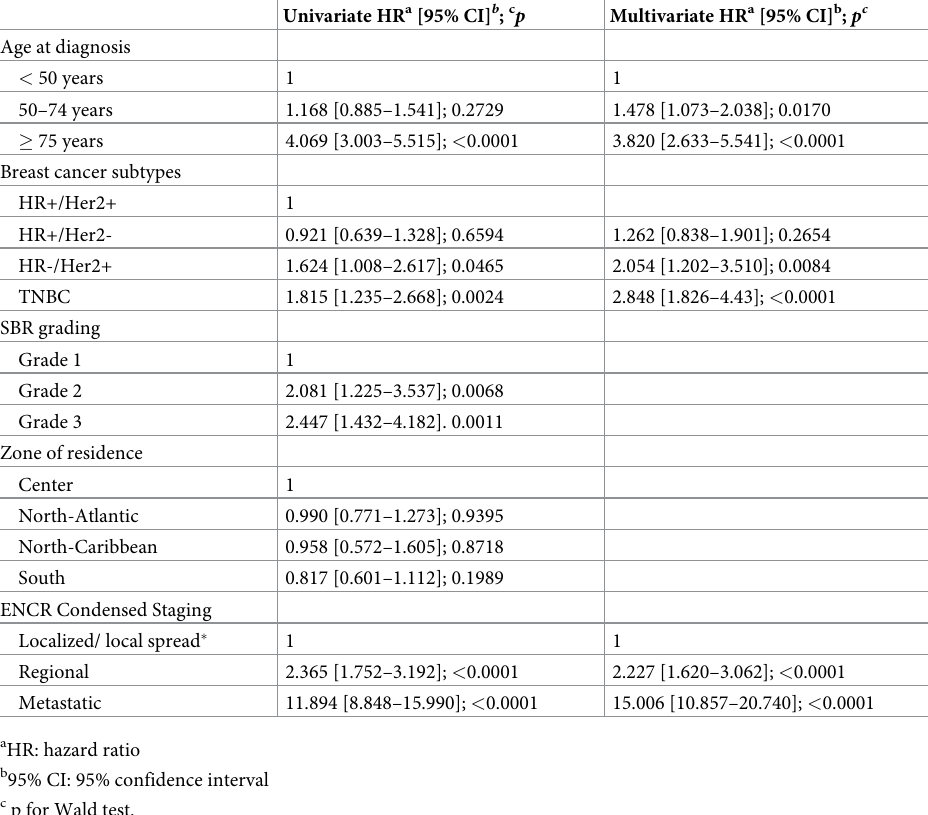
Table 3. Prognostic factors for breast cancer survival in Martinique,